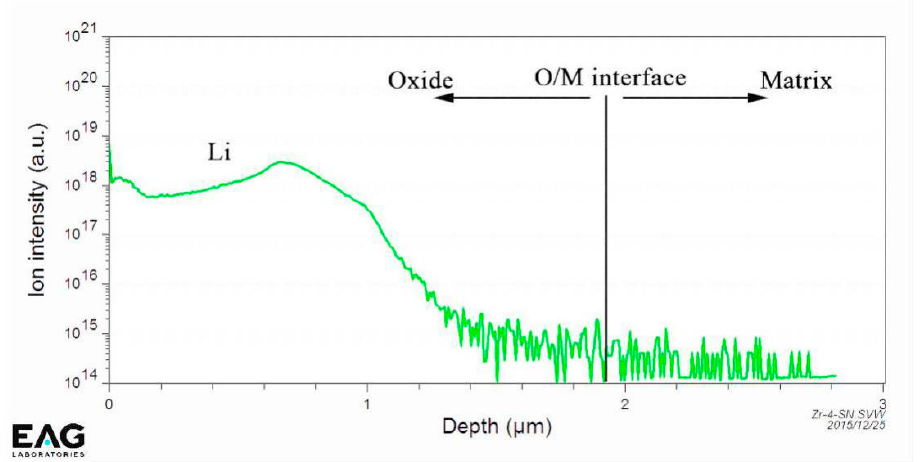
Figure 3. The distribution of Li + across the thickness of oxide film formed on the S N surface of the Zircaloy-4 specimen after corroding in lithiated water with 0.01 M LiOH at 633 K/18.6 MPa for 70 d. The 3D reconstruction maps for ZrO 2 (red), Fe (blue), Li (black) and Sn (green) in the needle-